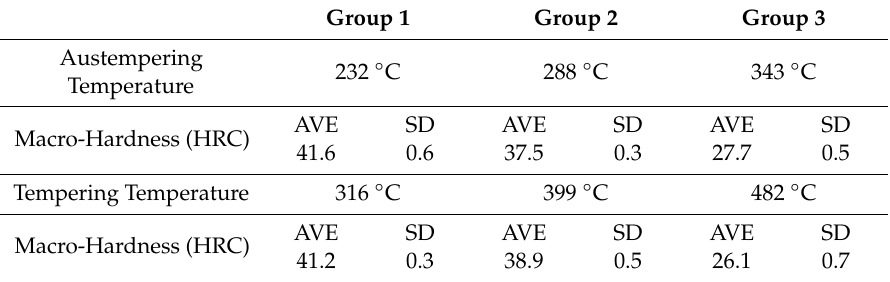
Table 6. Macro-Hardness of AGI and QTGI Specimens with Various Heat Treatment